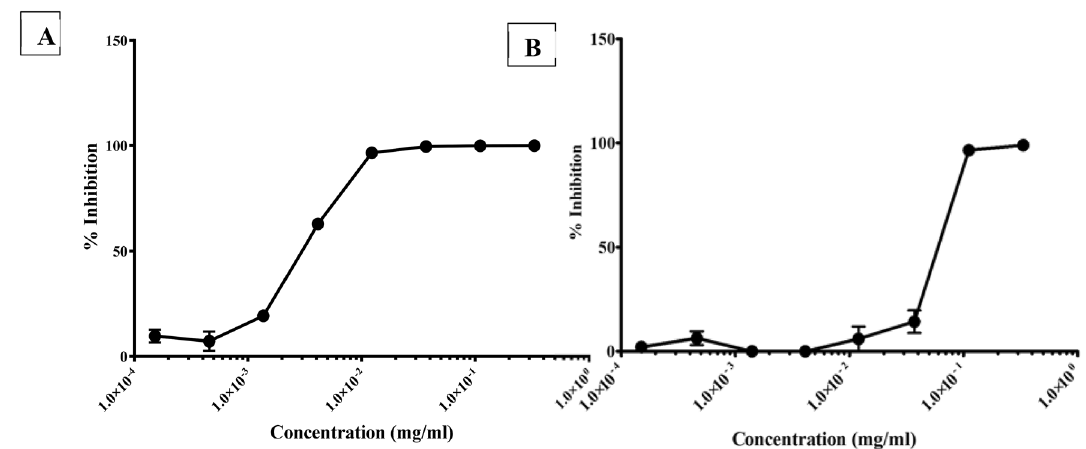
Figure 3. PHELA extract inhibition of SARS-CoV related coronaviruses. ( A ) SARS-CoV, and ( B ) MERS-CoV were incubated with the extract before infection of 293-T cells ACE.MF or Vero cells, respectively. After 72 h incubation the inhibition of infection was determined by measuring luminescence. Data shown represent the results of three independent experiments, and bars represent the means ± standard deviation.